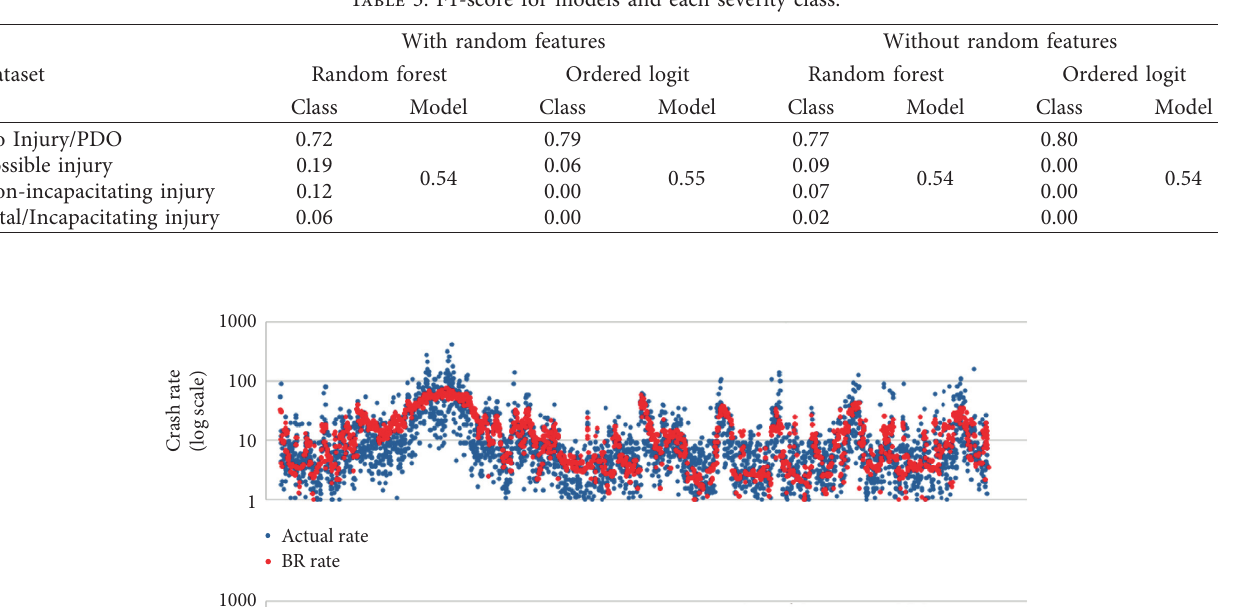
Figure 5: Distribution of severity-weighted and unweighted observed crash rates (2006 to 2009). Table 3: F1-score for models and each severity class.